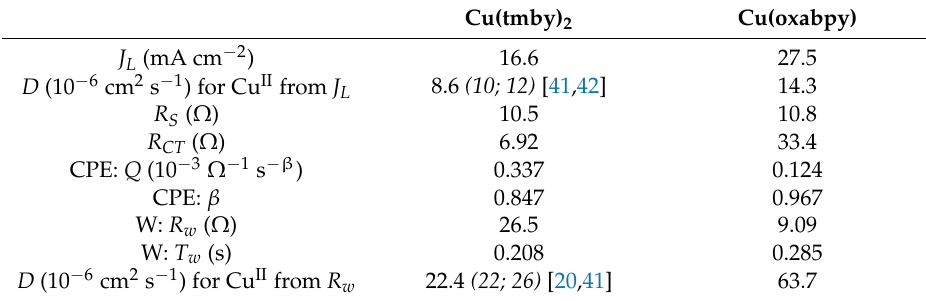
Table 4. Electrochemical characterization of symmetrical PEDOT-PEDOT cells. The first two rows list current density J L and diffusion coefficient D from the cyclovoltammograms. The equivalent circuit parameters for the electrochemical impedance spectra are: serial resistance R S , charge transfer resistance R CT , frequency-independent parameters Q and β for the constant phase element and resistance R W , as well as time constant T W , for the Warburg diffusion model. Diffusion coefficients from the electrochemical impedance spectra are shown in the last row. The diffusion coefficients were calculated from Equations (2) and (5), respectively. Previously reported values in